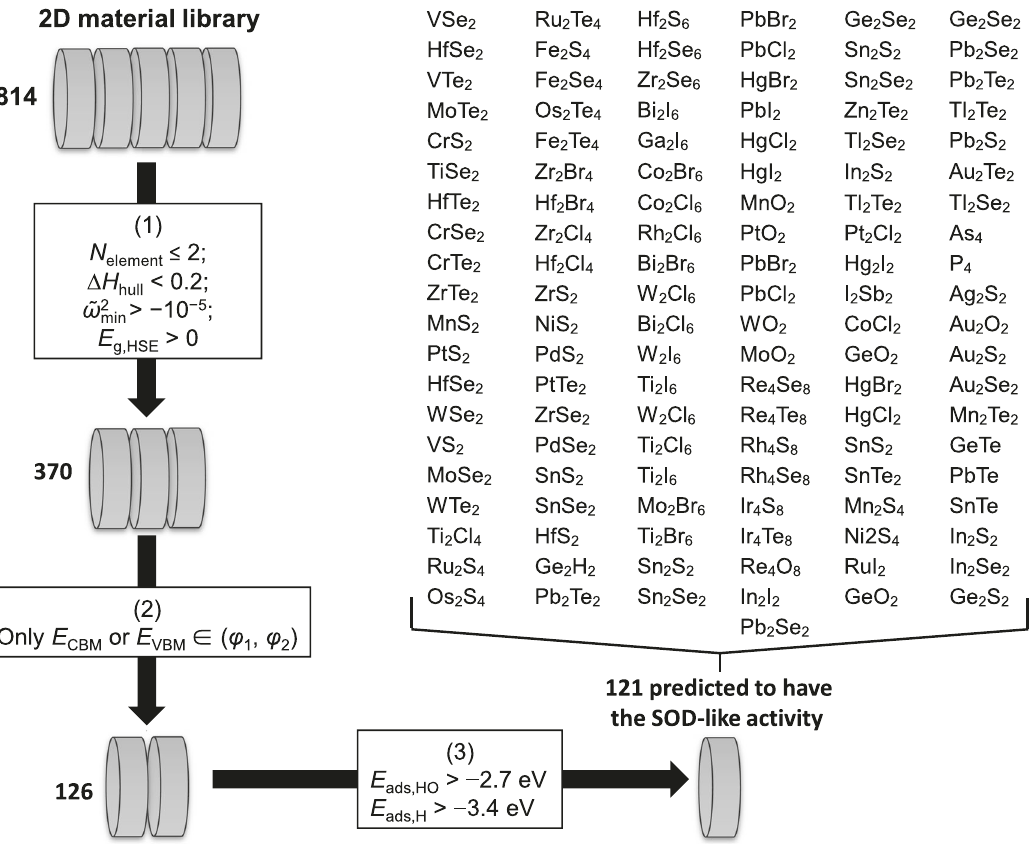
Fig. 5 Computational screening of two-dimensional nanomaterials as potential superoxide dismutase mimics. The screening was based on the library containing 3814 materials. Among them, 370 ones, which contained no more than two elements, had considerable thermodynamic and kinetic stabilities, and had an electronic bandgap, passed the fi rst step of screening. 126 ones, which had conduction band minimum or valence band maximum as the only intermediate frontier molecular orbital, passed the second step of screening. 121 ones, which further satis fi ed the adsorption energy criterion, passed the second step of screening and were predicted to have intrinsic superoxide dismutase-like catalytic